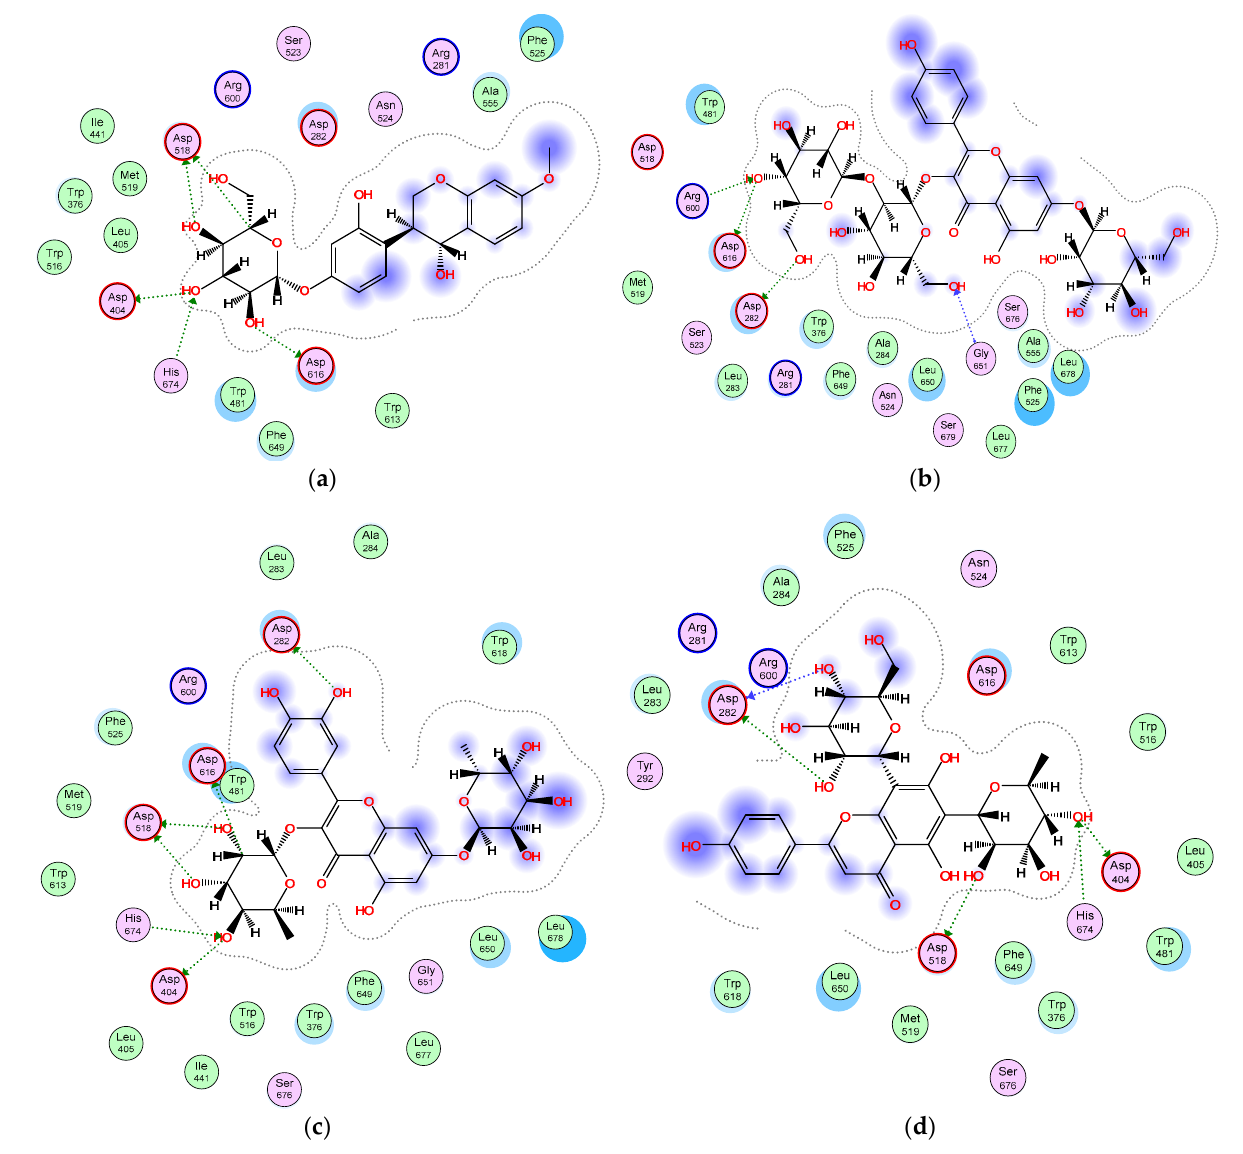
Figure 4. 2D diagram of the binding interactions of ( a ) 4,2 ′ ,4 ′ -trihydroxy-7-methoxyisoflavan-4 ′ -O- β -D-glucopyranoside, ( b ) kaempferol 3- O - β -D-glucosyl (1 → 2) β -D-galactoside 7- O - β -D-glucoside, ( c ) quercetin 3,7- O - α -L dirhamnoside, and ( d ) apigenin-6,8-di- C -rhamnosyl-glucosyl with the active site residues of the α -glucosidase receptor. Pink circles with red and blue borders indicate polar acidic and basic amino acids, respectively, and green circles indicate nonpolar amino acids.